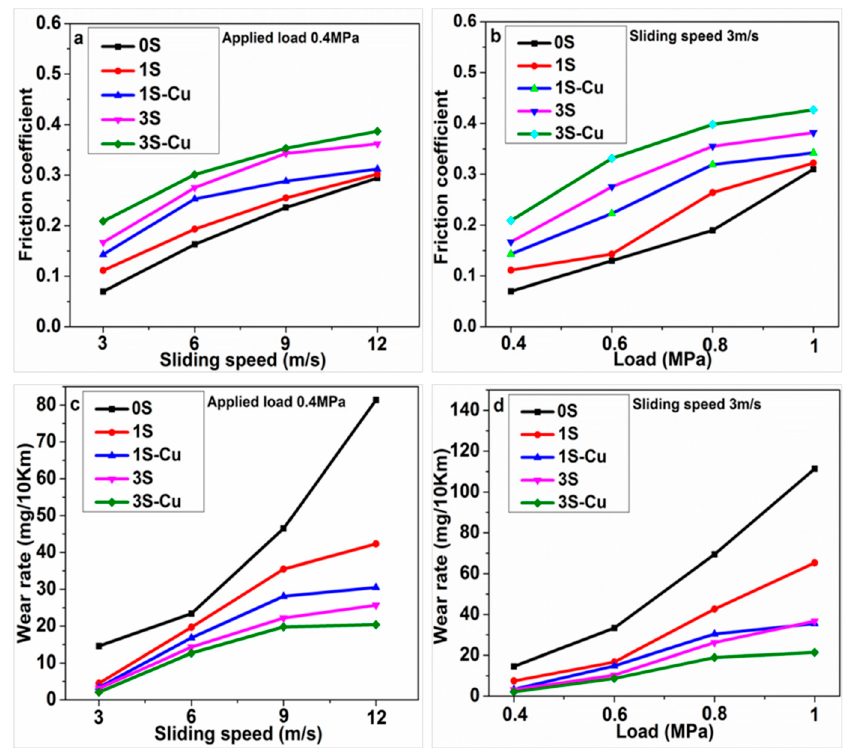
Figure 5. Variation of average friction coefficient ( a , b ) and wear rate ( c , d ) with sliding speed (a,c) and applied load (b,d).